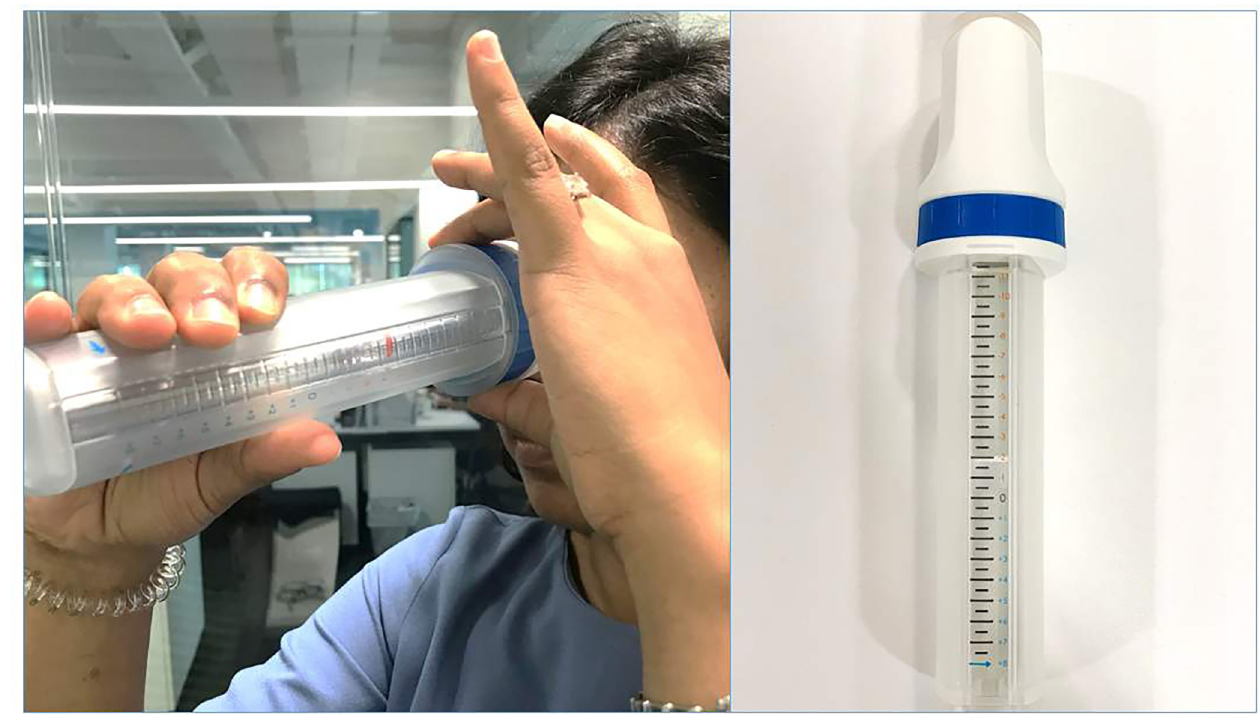
Fig 1. ClickCheck device and a patient being tested using the